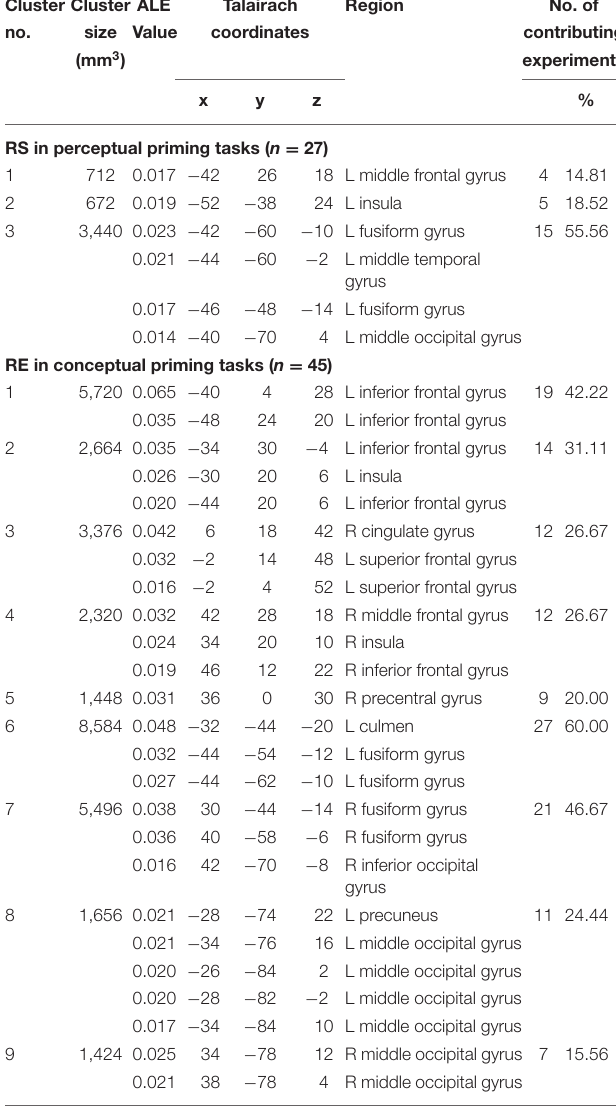
TABLE 3 | Brain regions showing RS in perceptual and conceptual priming separately. Cluster Cluster ALE Talairach Region No.